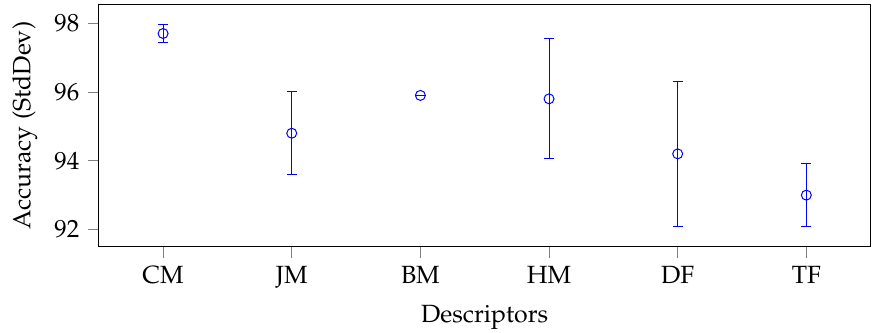
Figure 3. Average accuracy and standard deviation calculated on each descriptor category with the best classifier on average, for the Emphysema-CT data set.